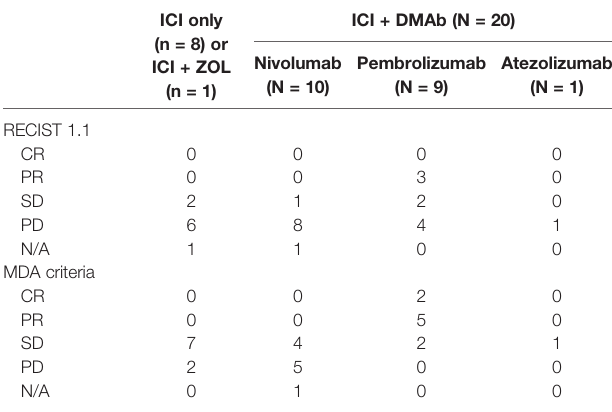
TABLE 3 | Therapeutic effect of ICI and DEMb concomitant therapy compared to ICI-only or ICI and ZOL therapy. ICI only (n = 8) or